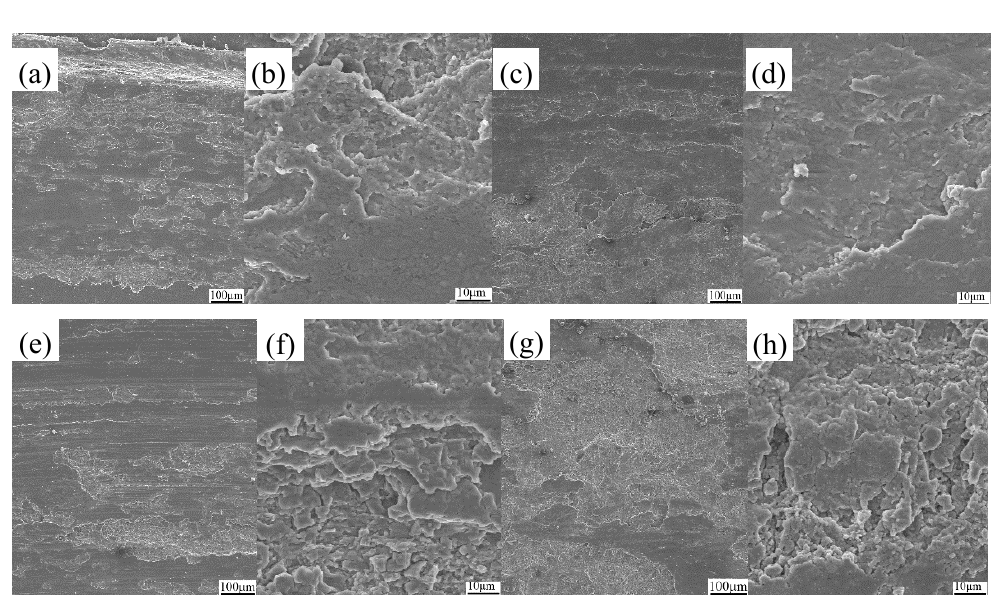
Figure 15. SEM images of the wear debris on 4.5 wt. % TiB 2 /7075 specimens cast at 720 ℃ under different frictional loads: ( a,b ) 30 N, ( c,d ) 60 N, ( e,f ) 90 N, and ( g,h ) 120 N. 4. Conclusions In this study, rheocasting of the TiB 2 /7075 aluminum matrix composite was successfully carried out with the addition of appropriate amounts of TiB 2 particles into the 7075 aluminum alloy via an in situ synthesis method and with the use of a serpentuator. The frictional wear properties of gravity cast and rheocast composites were compared, and the main conclusions are as follows: 1. TiB 2 particles were successfully added into the 7075 aluminum alloy via in situ synthesis. TiB 2 particles were mainly distributed at grain boundaries, and some of the large particles have sizes in the range of 1–2 μ m, whereas most of the particles have submicron sizes. The added TiB 2 particles effectively optimize the microstructure of the gravity cast 7075 aluminum alloy because of the transformation from coarse dendrites to rosette grains. Adding 4.5 wt.% TiB 2 results in the best optimization. TiB 2 can be used as a crystallization nuclei for heterogeneous nucleation to effectively increase the number of primary nuclei and block the solid-liquid interface migration when the grains grow. Rheocasting of the 7075 aluminum alloy was successfully achieved via the combined use of in situ TiB 2 particles and a serpentuator. Favorable near-spherical grains were obtained. The average grain sizes are 23 μ m, and the shape factors are 0.96 of rheocast 4.5 wt.% TiB 2 /7075. 2. At a friction velocity of 0.15 m/s, the wear mechanisms of the rheocast 7075 aluminum alloy are adhesive wear and delamination wear, and delamination wear begins to dominate as the load increases. The wear mechanism of the rheocast TiB 2 /7075 aluminum matrix composite is three-body abrasion and fatigue wear. Fatigue wear becomes the primary mechanism under loads that are higher than 90 N.